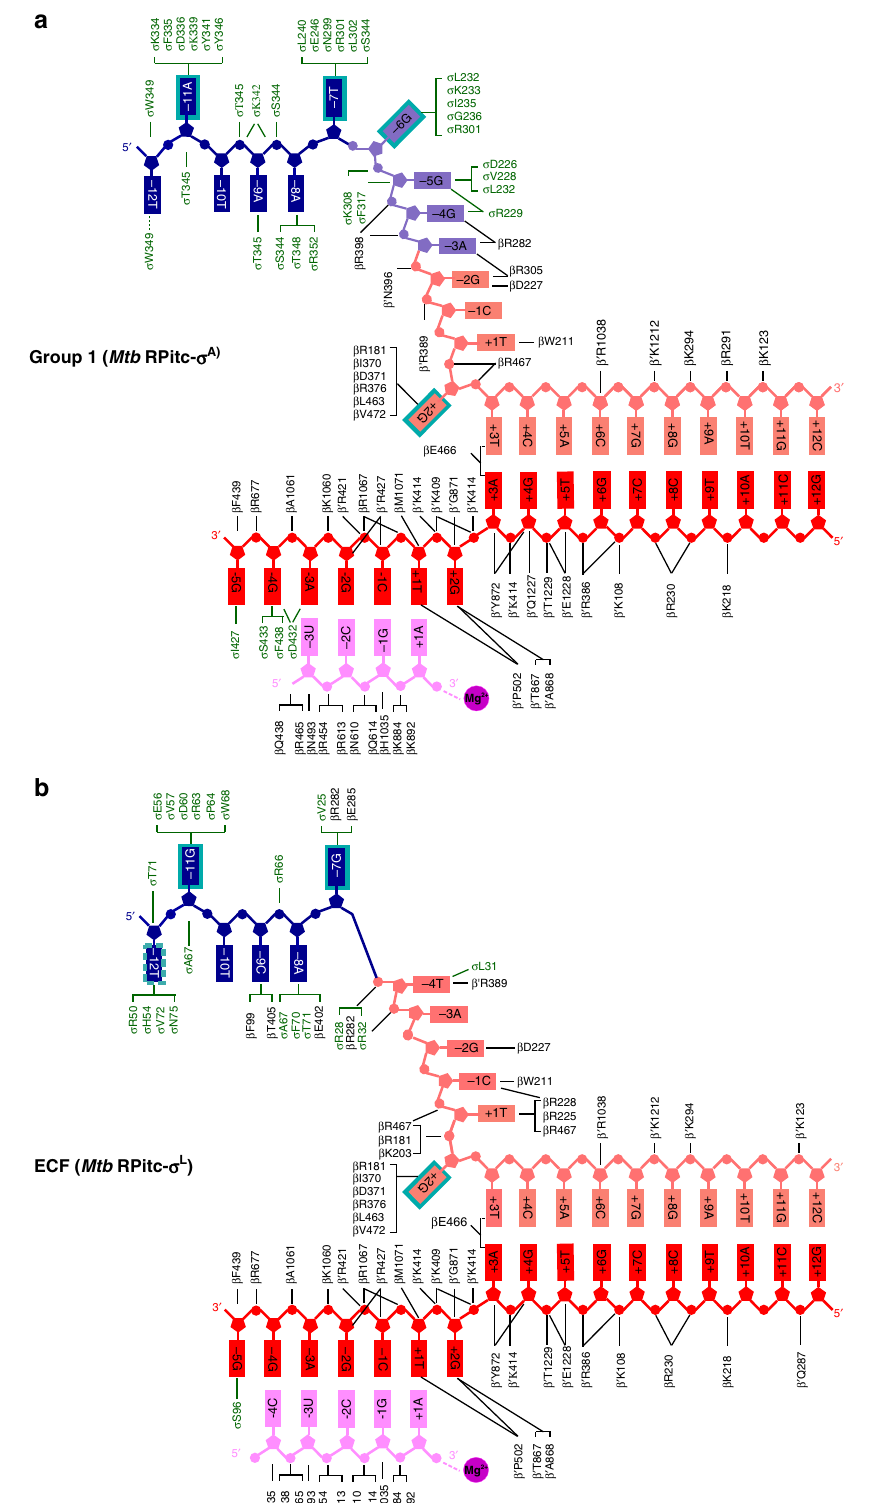
Fig. 3 Protein – nucleic acid interactions by group-1 and ECF σ factors: summary. a Summary of protein – nucleic acid interactions in Mtb RPitc- σ A . Black residue numbers and lines, interactions by Mtb RNAP; green residue numbers and lines, interactions by Mtb σ A ; blue, -10 element of DNA nontemplate strand; light blue, discriminator element of DNA nontemplate strand; pink, rest of DNA nontemplate strand; red, DNA template strand; magenta, RNA product; violet circle, RNAP active-center Mg 2 + ; cyan boxes, bases unstacked and inserted into protein pockets. Residues are numbered as in Mtb RNAP. b Summary of protein – nucleic acid interactions in Mtb RPitc- σ L . Green residue numbers and lines, interactions by Mtb σ L . Other colors are as in ( a ). See Supplementary Figs. 3 – 5 and